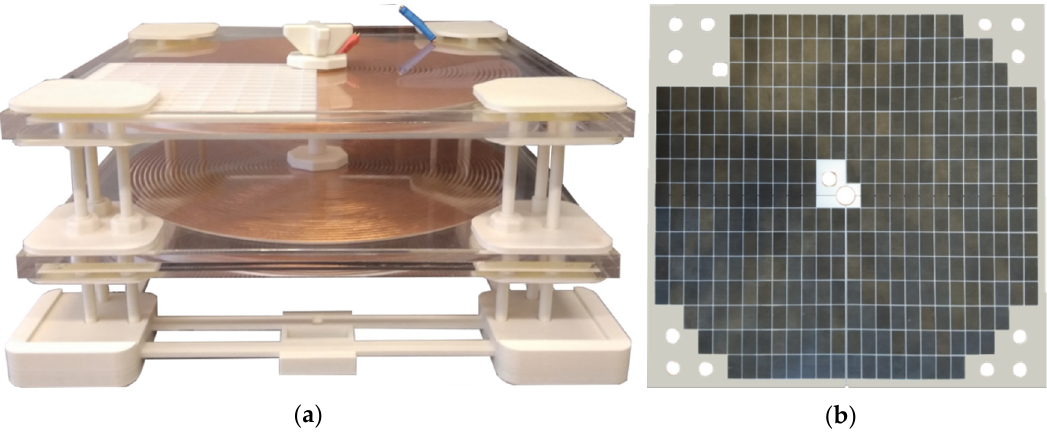
Figure 12. Coupling coils with positioning mechanism ( a ) and EM field shielding ( b ).